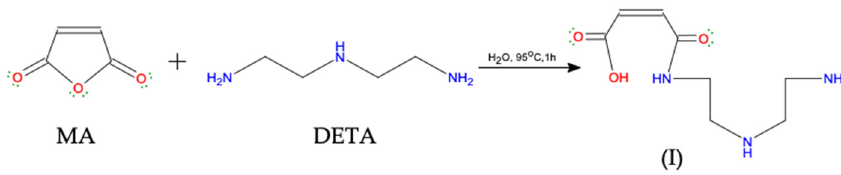
Figure 2. Reaction of malic anhydride (MA) with diethylenetriamine (DETA).